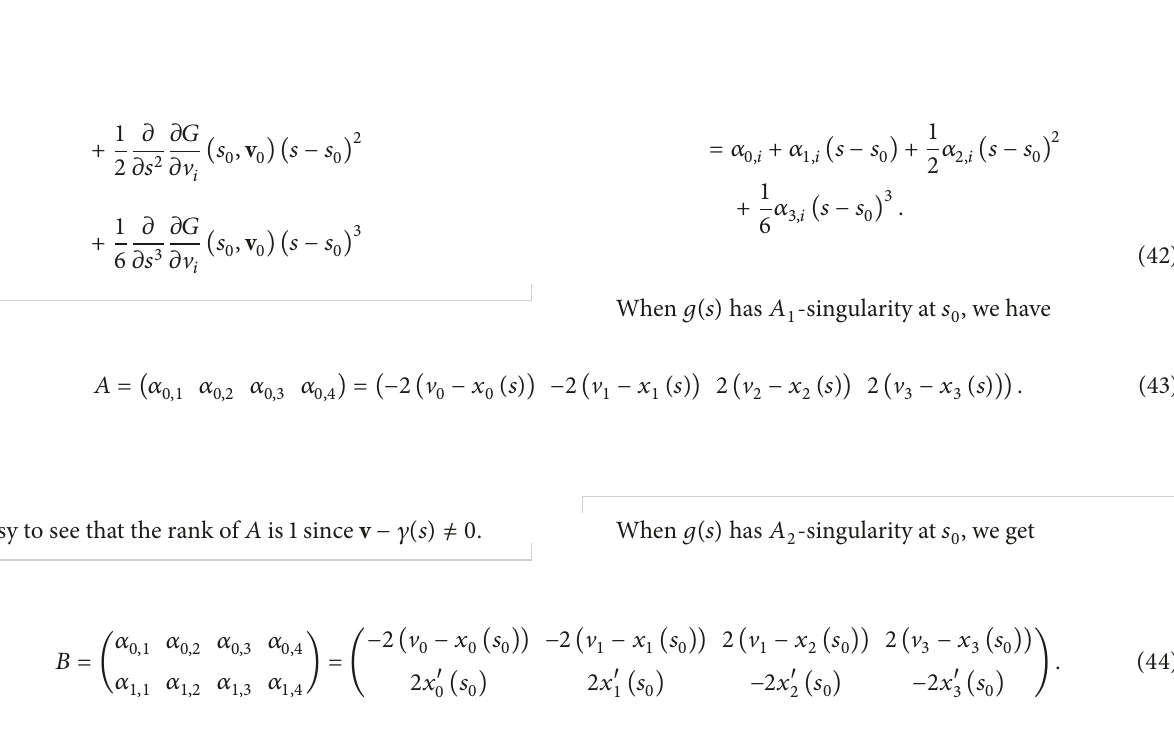
Figure 6: Projection of butterfly on 𝑥 1 𝑥 2 𝑥 3